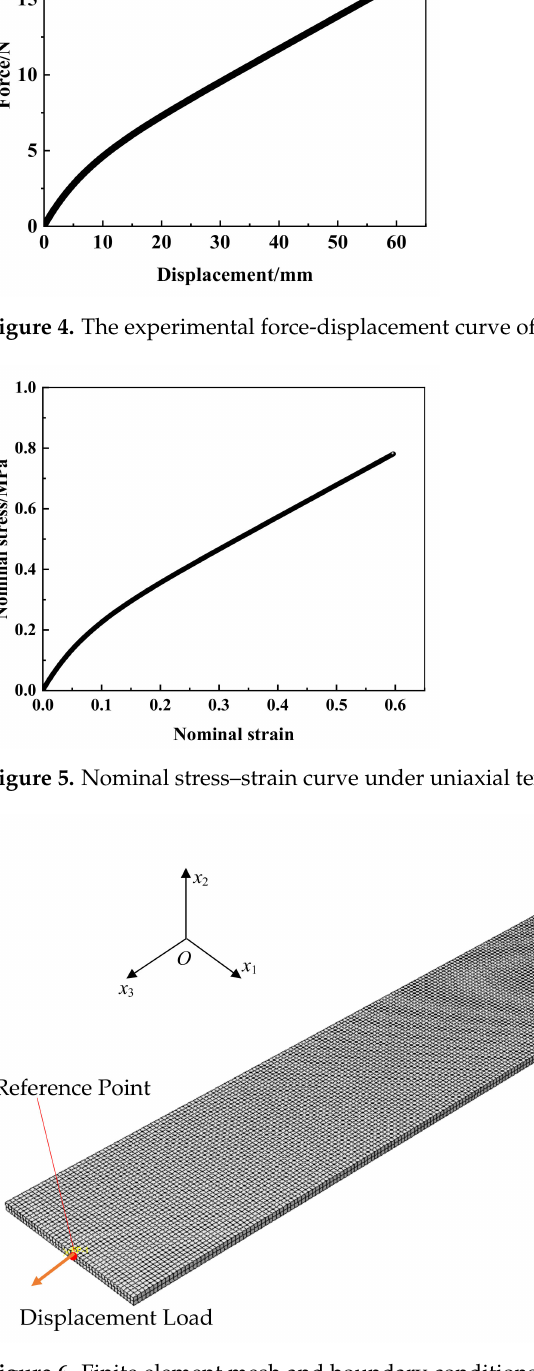
Figure 6. Finite element mesh and boundary conditions of silicone rubber